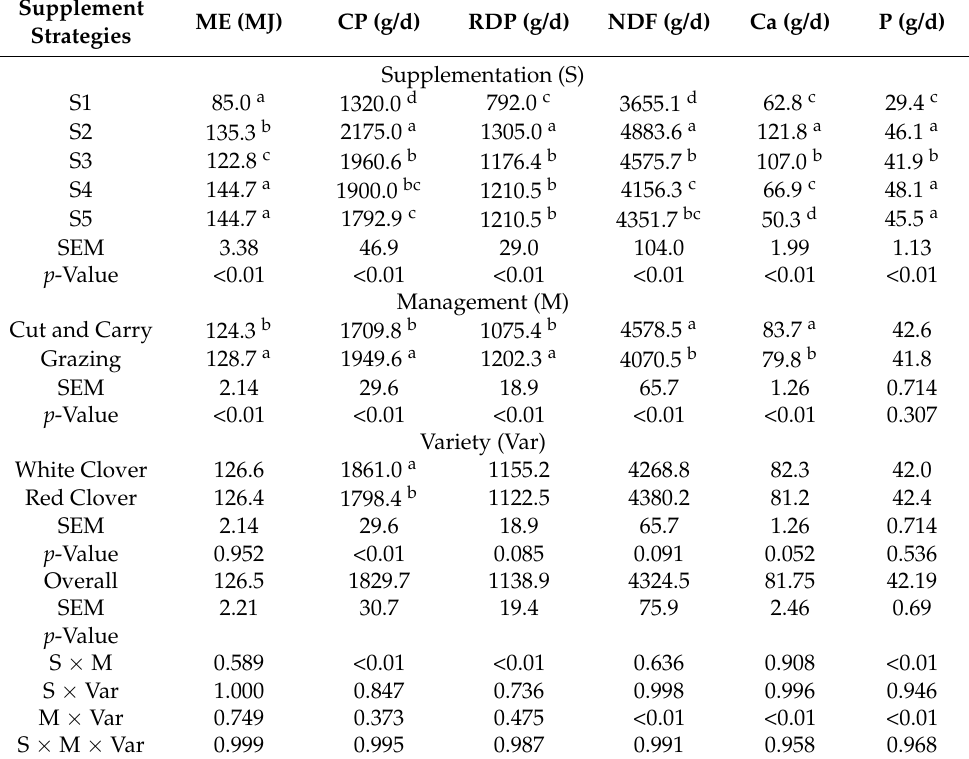
Table 5. Energy (MJ), crude protein, rumen degradable protein (g/cow day) of different strategies, five different simulated supplementations (S) in dairy cattle feed under two feeding systems (grazing or cut-and-carry), and two forage crops (red clover or white